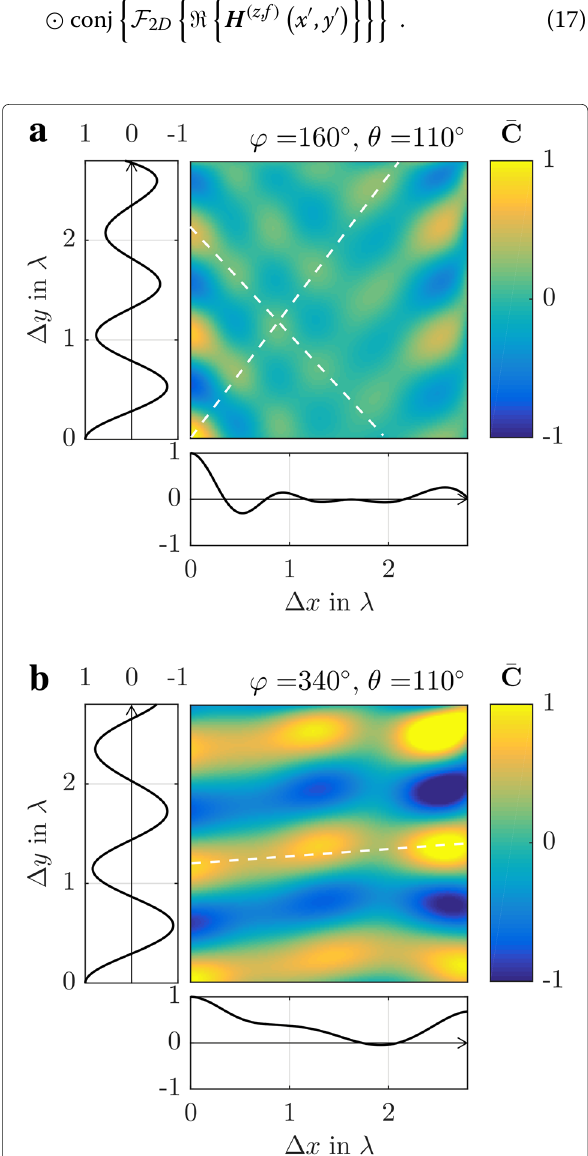
Fig. 13 Spatial correlation plot at ϕ = 160 ◦ ,340 ◦ and θ = 110 ◦ . For the ( a ) wall reflection at ϕ = 160 ◦ , the pattern shows an interference of two plane waves, supporting the TWDP fading assumption. For ( b ) LOS at ϕ = 340 ◦ , we observe a spatial correlation pattern dominated by one wave. The white dashed lines illustrate plane wave phase